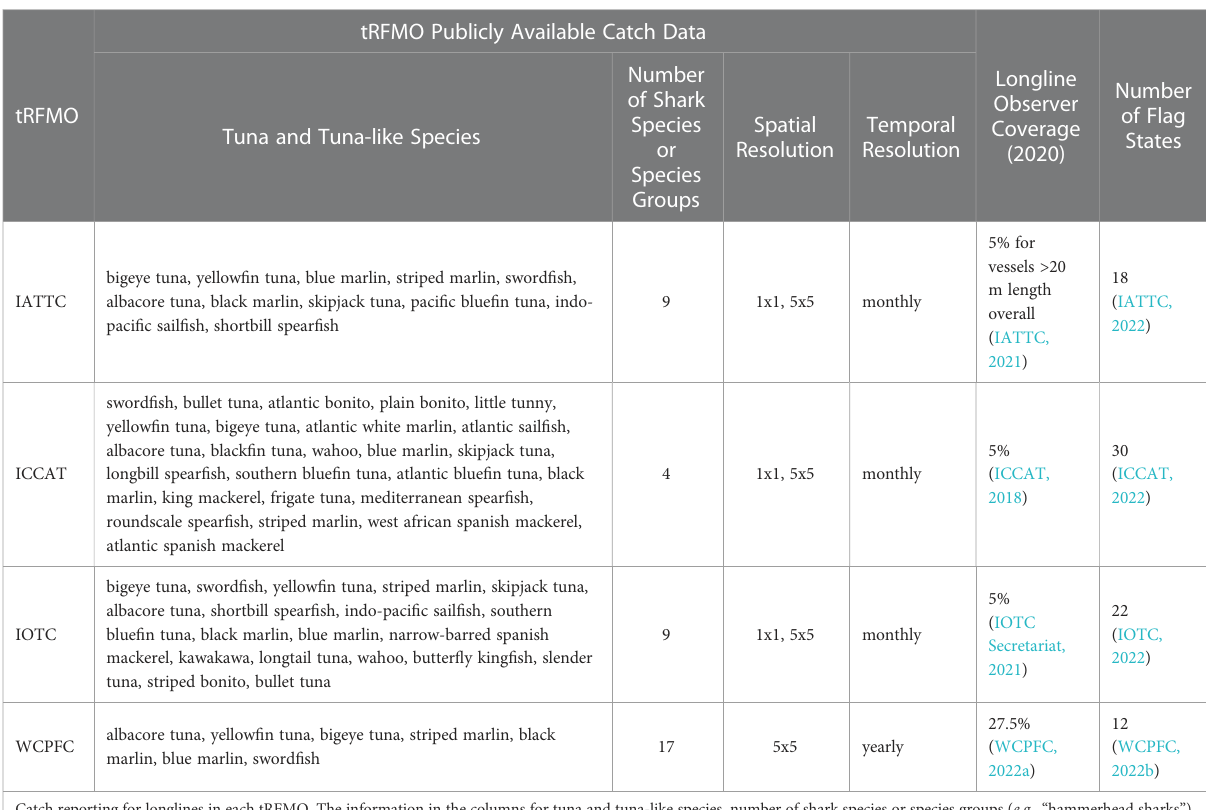
TABLE 2 Longline catch reporting